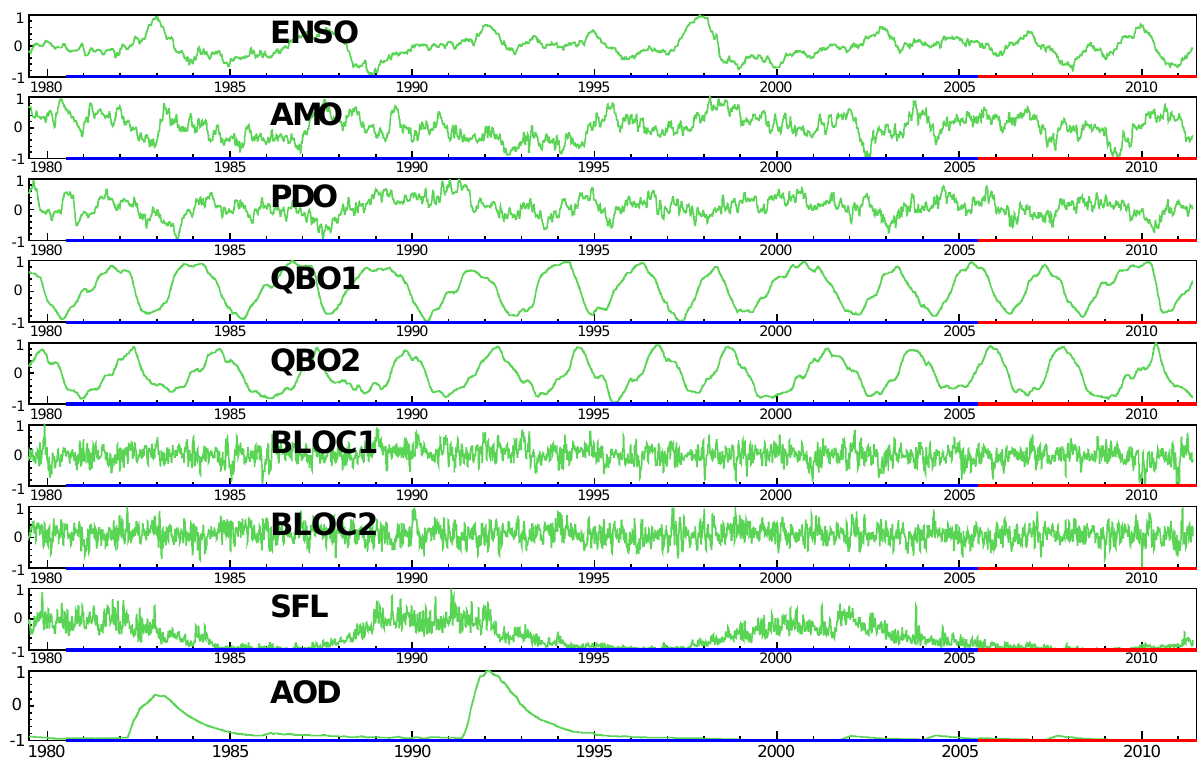
Fig. 1. The different external factors in green as used in this study, omitting sine, cosine, and trend terms for simplicity. Blue denotes the training and red the hindcast